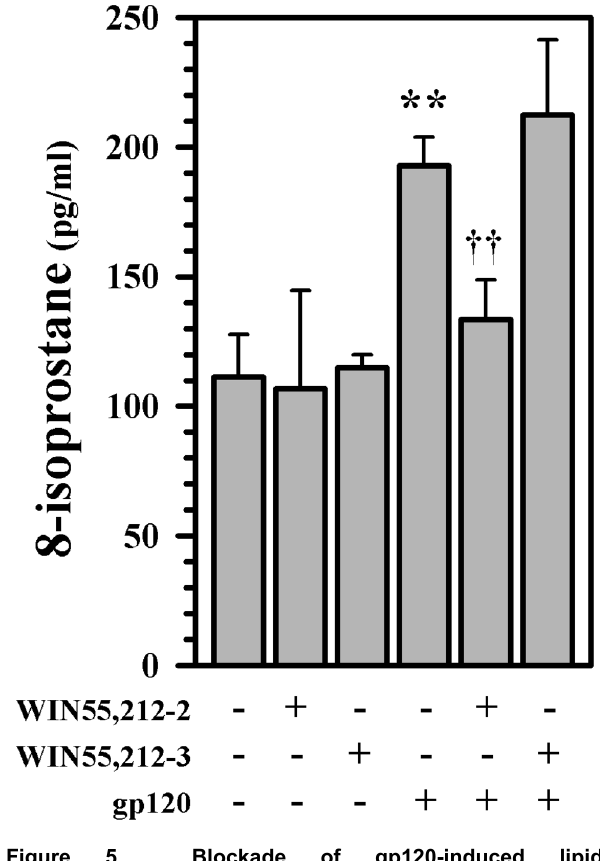
Figure 5. Blockade of gp120-induced lipid peroxidation. Human mesencephalic neuronal/glial cultures were untreated (C) or pretreated with WIN55,212-2 or WIN55,212-3 (0.3 μM) for 3h prior to gp120 (10 nM) treatment for 5 days followed by supernatant collection for 8-isoprostane assay. Data are mean ± SD of triplicates and representative of 3 separate experiments using different brain tissue